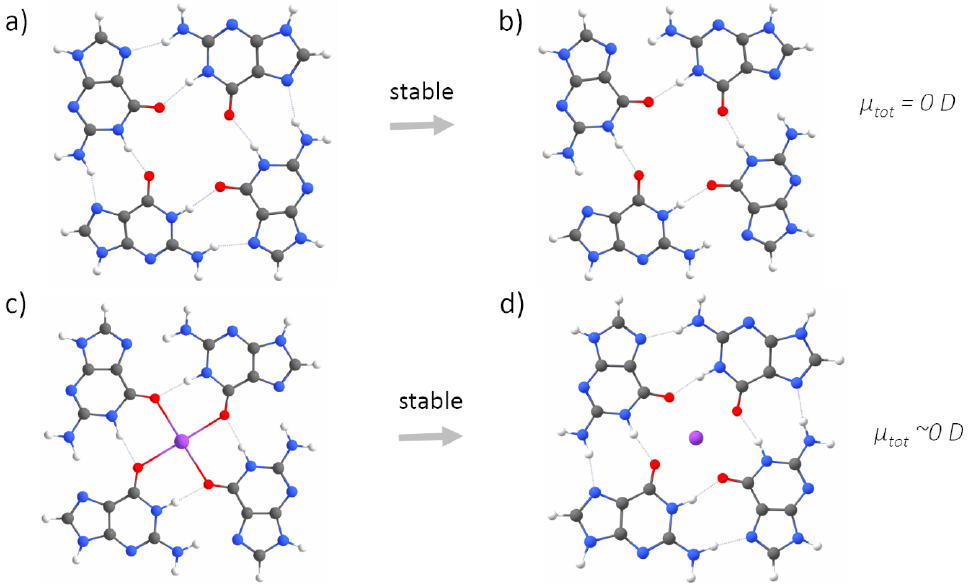
Figure 7. The optimization of a G-tetrad without ( a → b ) and with ( c → d ) a metal (here, potassium) cation, calculated at the QM level of theory. The optimization in both cases did not much change the mutual arrangement of the guanines. The potassium ion moved out of the plane of the G-tetrad upon optimization. A G-tetrad without a cation remains stable, as guanines are held together by the attractive forces originating from the cancellation of dipole moments, along with the circular network of hydrogen bonds via Hoogsteen